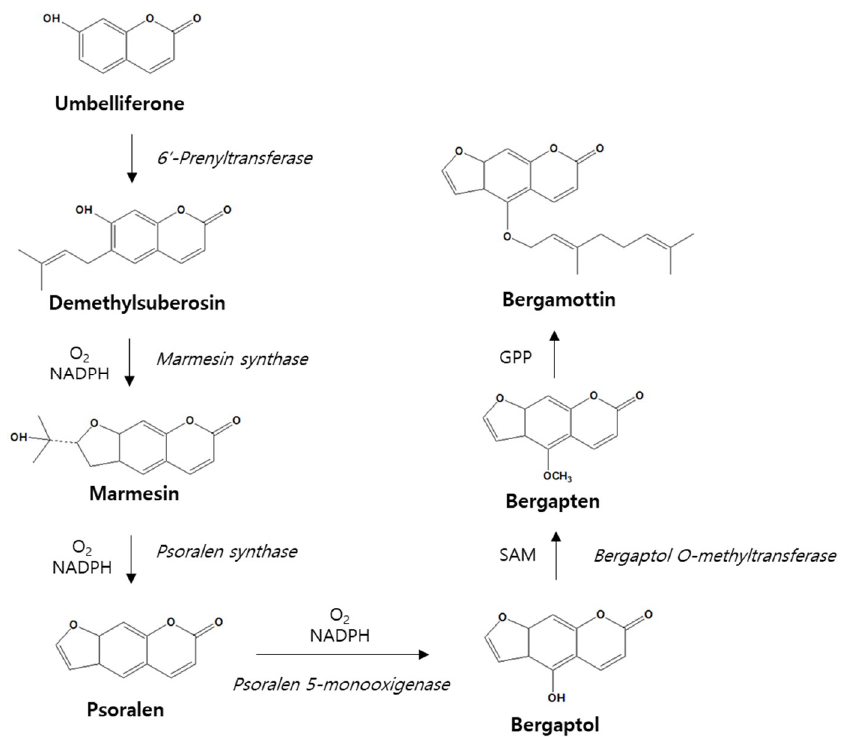
Figure 2. Biosynthesis pathway of bergamottin.